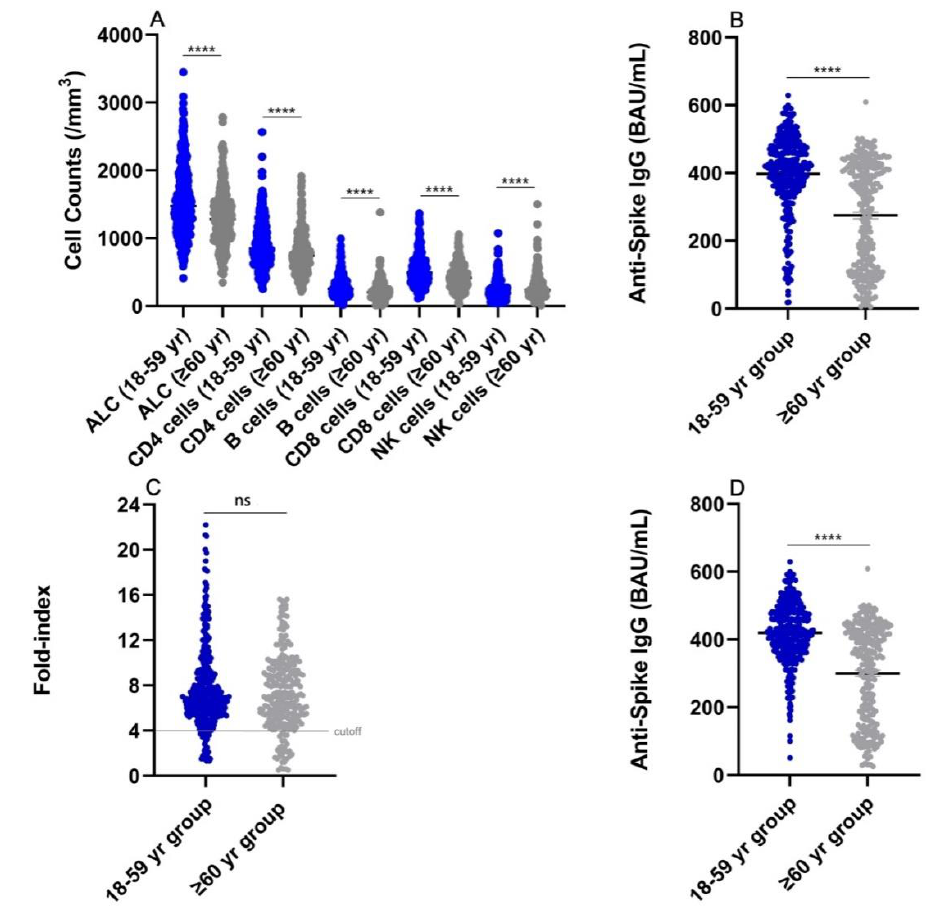
Figure 1. Immunological characteristics of 627 individuals. ( A ) Naïve cellular immunological pa- rameters of the 627 cases who received physical examinations. These naïve immune cells wane significantly, while the natural killer (NK) cell counts increase significantly in older adults. ALC, abso- lute lymphocyte count. ( B ) The anti-spike IgG levels after complete vaccination of the 627 cases. The quantitative level of the anti-spike IgG is significantly lower in the ≥ 60-year group (median 307.2, IQR 118.2–417.3 BAU/mL) than that in the 18–59-year group (median 416.8, IQR 355.7–479.2 BAU/mL, p < 0.0001). Mean and standard error of the mean (SEM) are shown. ( C ) The vaccine-induced re- sponses using at least a four-fold increase in antibody titer from baseline in 627 cases. There are 7.5% of poor or non-responders (fold-index < 4) among the 18–59-year group and 11.7% in the ≥ 60-year group. The level of anti-spike IgG ranges (the 1st–99th percentile) for responders (fold–index ≥ 4) are 43.9–592.0 BAU/mL in combination of the 18–59-year and the ≥ 60-year groups. A cut-off line at fold-index 4 is shown. ( D ) In the responder group (fold-index ≥ 4), levels of anti-spike IgG for the 1st – 99th percentile are 131.8 – 592.3 BAU/mL in the 18 – 59-year group and 29.7 – 500.9 BAU/mL in the ≥ 60 -year group. Mean and SEM are shown. **** p < 0.0001. ns, not significant.